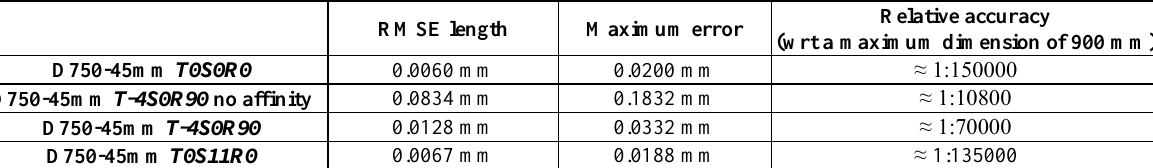
Table 5. Difference between target coordinates measured with the reference system D750-50mm and D750-45mm.